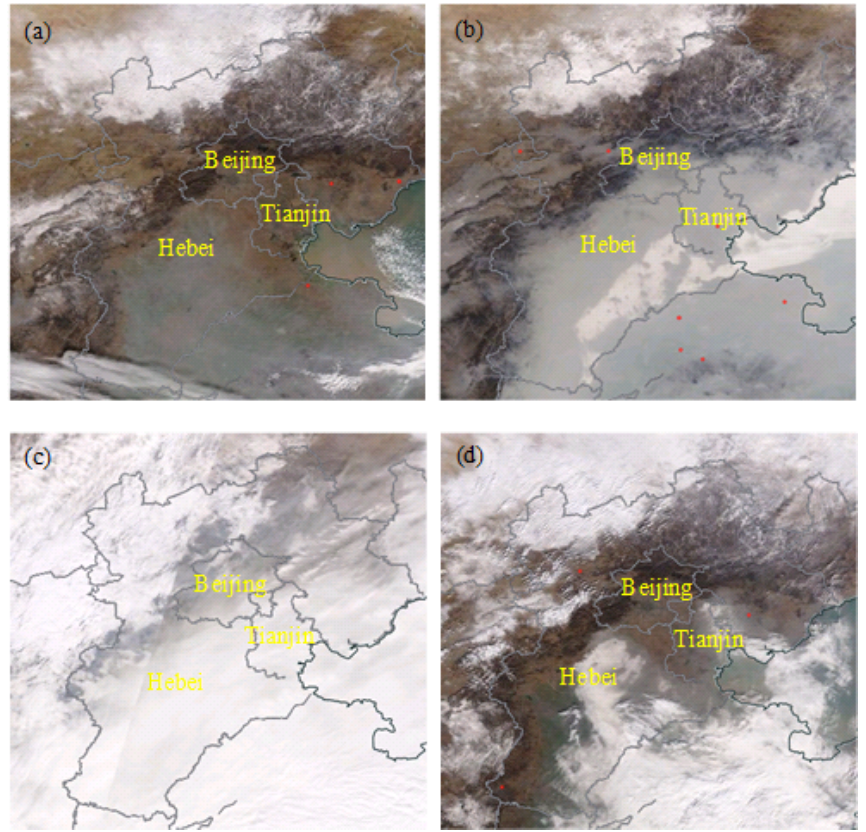
Figure 3. MODIS images of the Beijing–Tianjin–Hebei region on 15 December (a) , 18 December (b) , 21 December (c) and 22 December (d) . Both maps were obtained from the following website: https://worldview.earthdata.nasa.gov/ (last access: 28 August